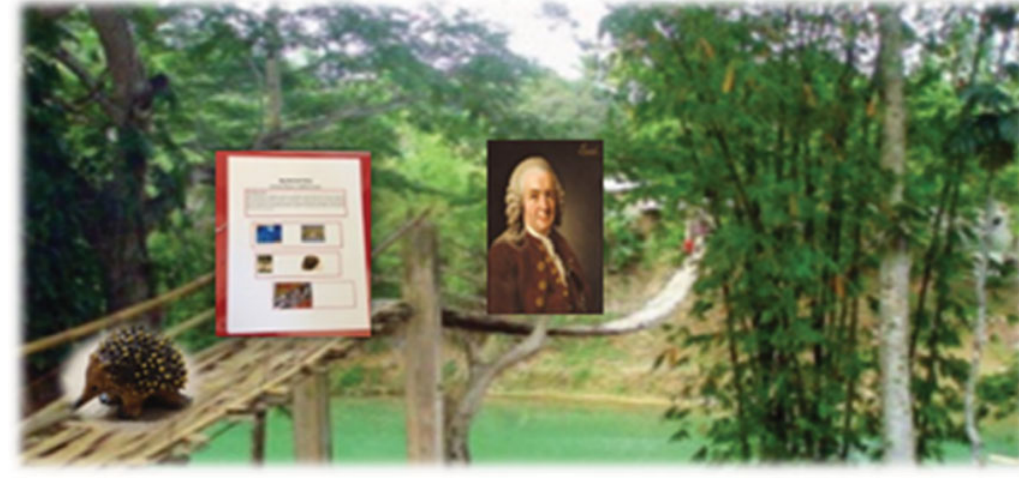
(Colour online) Walking on the bridge: Porky and narratives interface